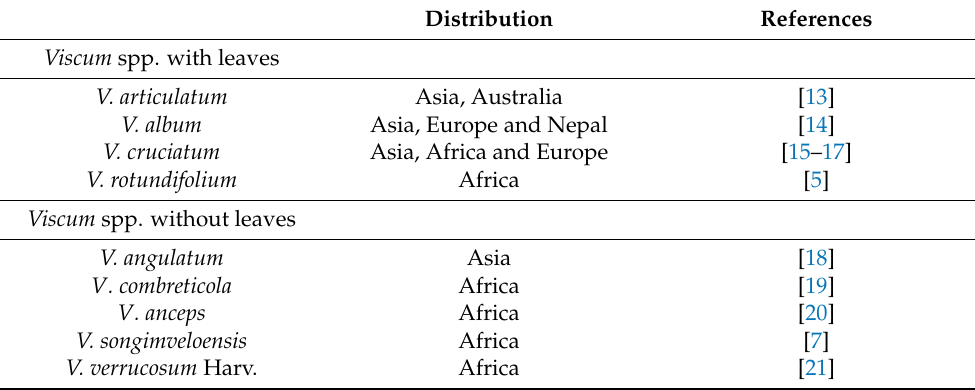
Figure 2. Viscum verrucosum Harv. in North West Province, photos taken by O Hawu.